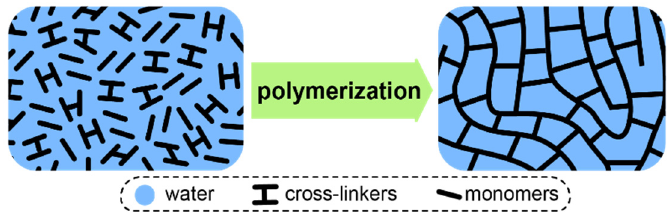
Figure 5. Formation of a typical highly cross ‐ linked membrane via polymerization of aqueous or amide solutions of ionogenic monomers.